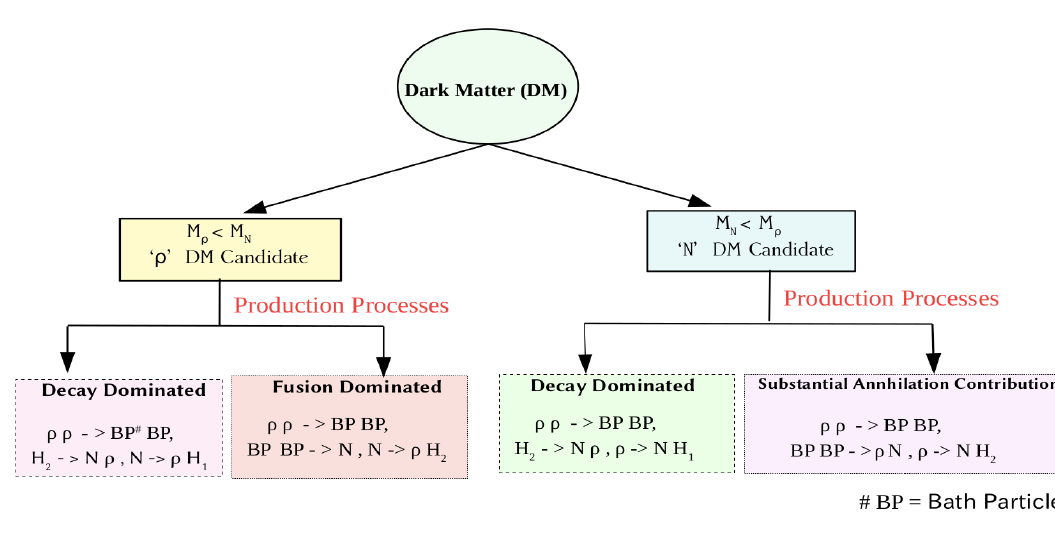
Figure 4 . Schematic diagram representing different scenarios, which we consider in this